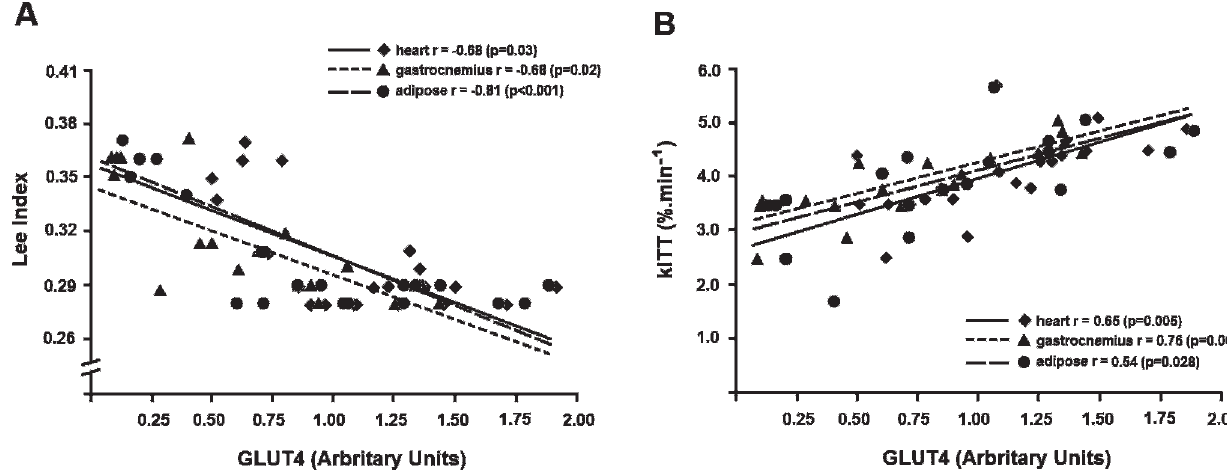
Figure 4 - Panel A: Scattergram plot of the GLUT4 protein content in the plasma membrane and the Lee index; Panel B: Scattergram plot of the GLUT4 protein content in the plasma membrane and the insulin sensitivity, evaluated by kITT, for all studied